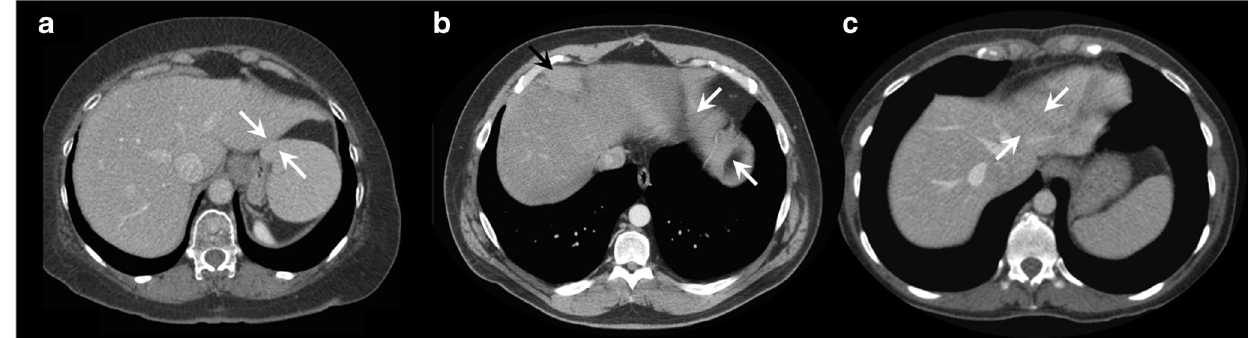
continuous borders found near the liver dome ( arrows ). c Axial enhanced CT image of a 73-year-old man shows partial volume averaging between the left liver and the heart ( arrows )